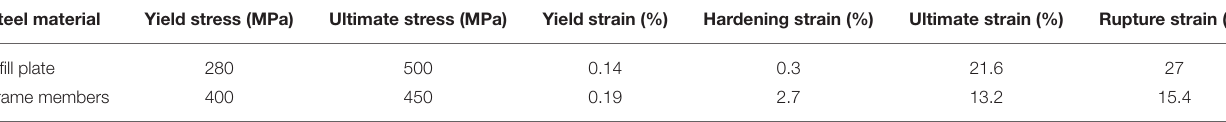
TABLE 1 | Mechanical properties of steel materials.